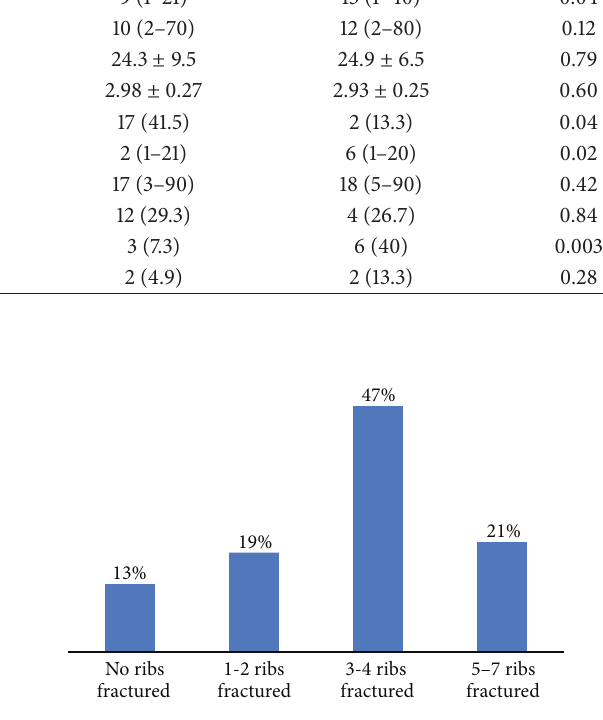
Figure 2: Number of ribs